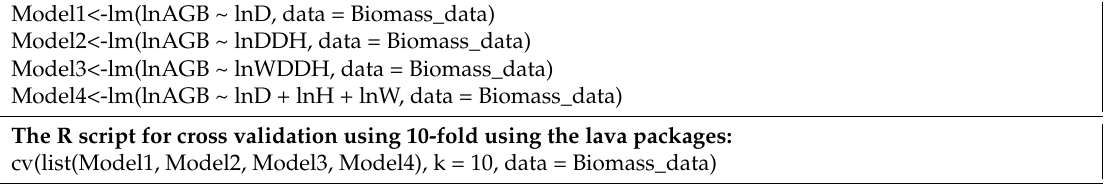
Table A3. R scripts for the four models.